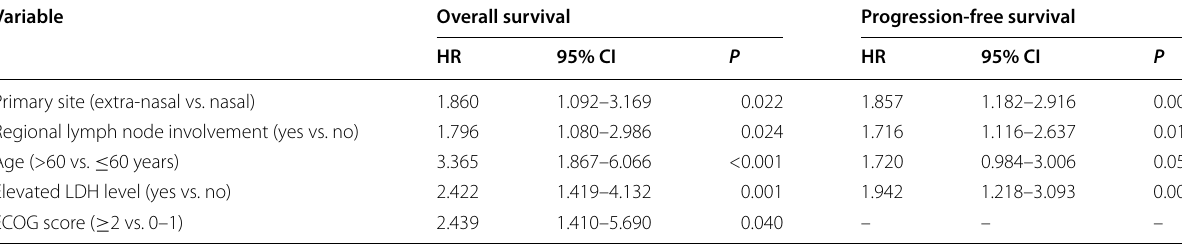
HR hazard ratio, CI confidence interval, UADT-ENKTCL upper aerodigestive tract-extranodal natural killer/T-cell lymphoma, LDH lactate dehydrogenase, LTI local tumor invasiveness, ECOG eastern cooperative oncology group